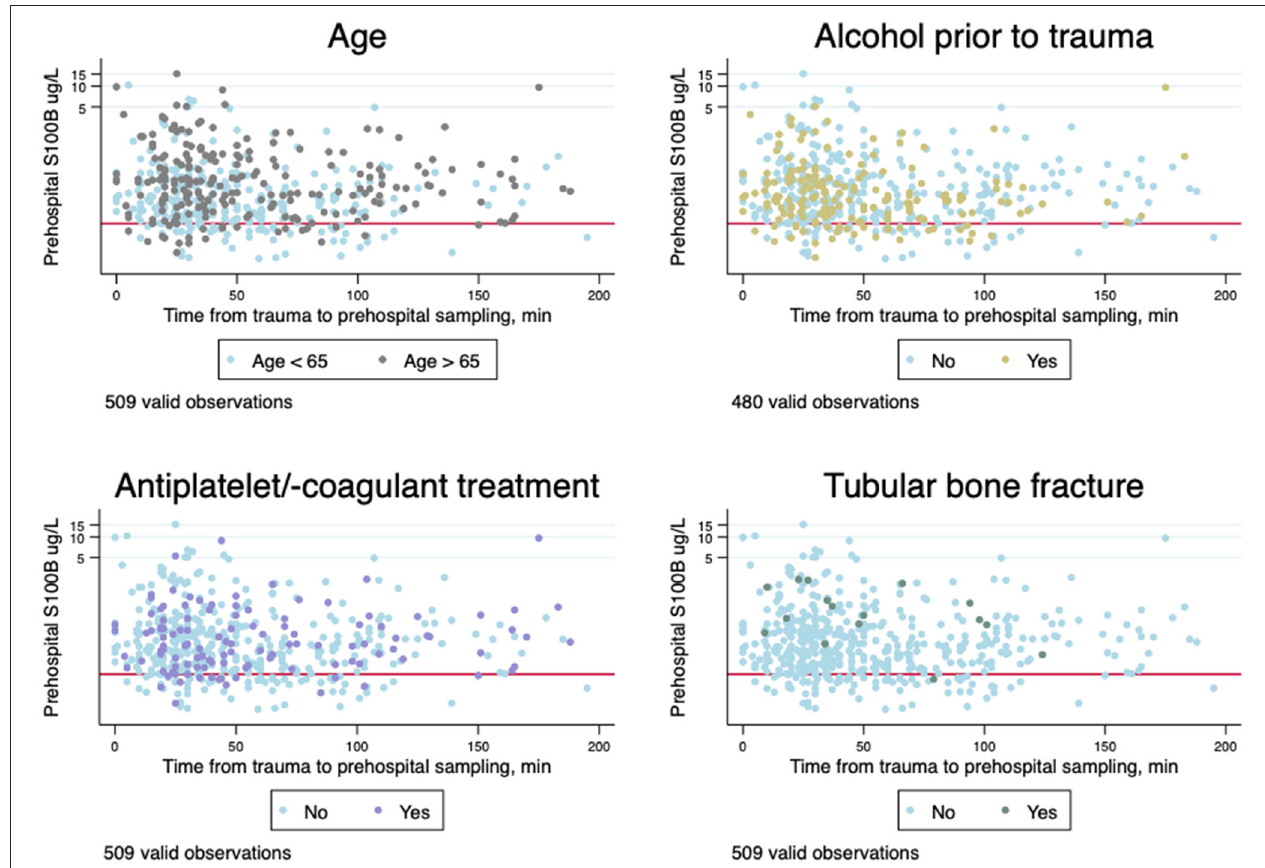
FIGURE 3 | Scatterplots of time from trauma to blood sampling in minutes (the first 4h) on ordinary scale and prehospital serum S100B concentrations in µ g/l a logarithmic scale stratified by age above/below 65 years, consumption of alcohol prior to trauma, antiplatelet/-coagulant treatment, and tubular bone fracture in addition to traumatic pbrqain injury (TBI). The red lines indicate guideline cut-off at 0.10 µ